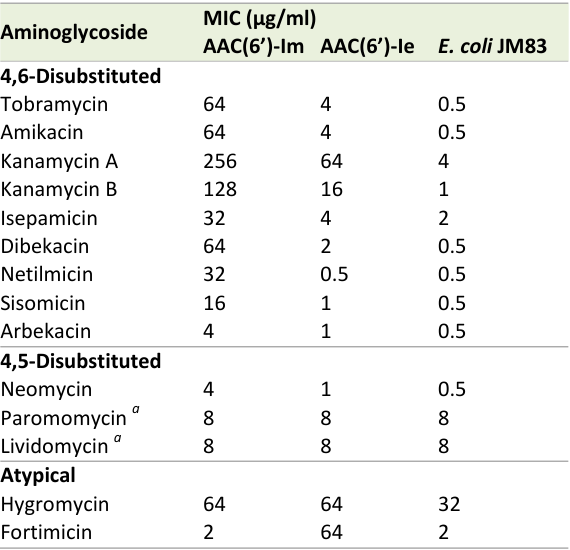
TABLE 1. MIC profile of aminoglycosides for E. coli JM83 expressing AAC(6’)-Im and